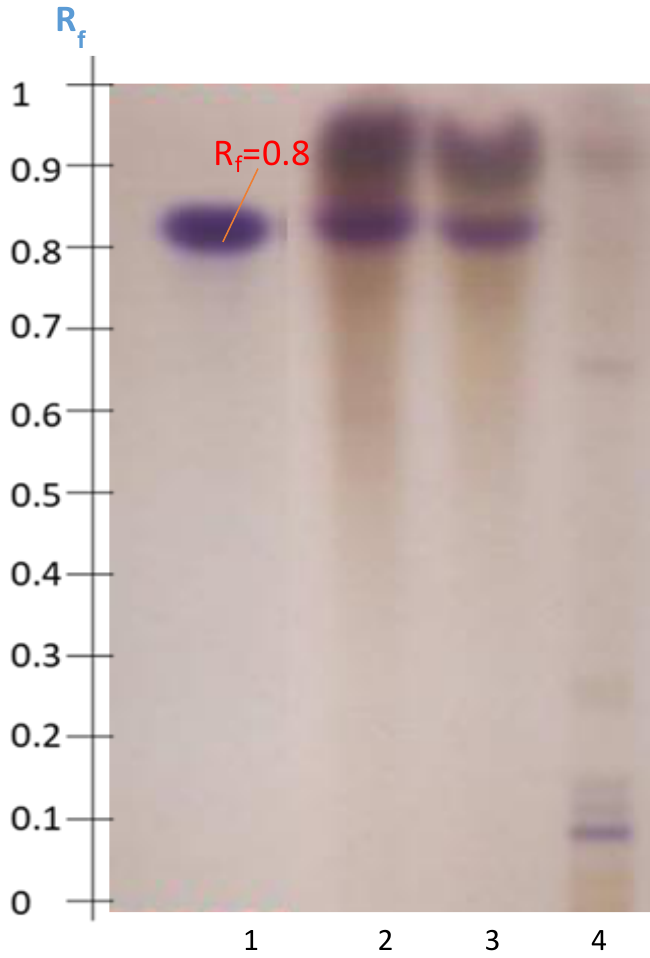
Figure 10. HPTLC profile obtained after visualization with anisaldehyde-H 2 SO 4 using the SS2 system. Chloroform phases of the hydrolyzed soyasaponin standard (Track 1) and of the hydrolyzed Zaghouan-P3 extract (Tracks 2 and 3) and the Zaghouan-P3 extract that was not hydrolyzed (Track 4).